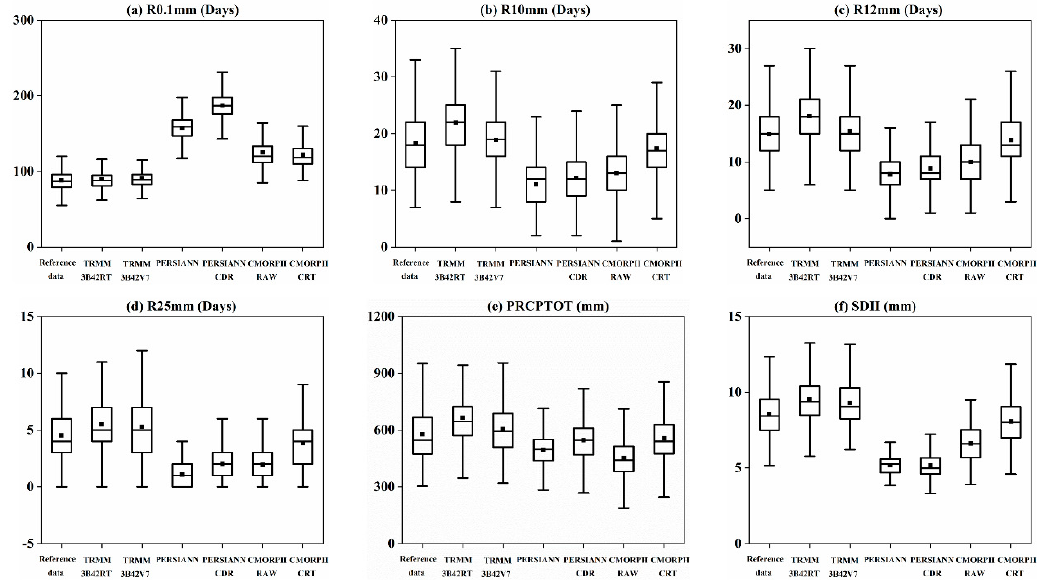
Figure 7. Boxplots for the six absolute threshold indices ( a ) R0.1mm, ( b ) R10mm, ( c ) R12mm, ( d ) R25mm, ( e ) PRCPTOP and ( f ) SDII for the reference data and the six SPPs. The upper and lower edges of the box mark the upper and lower quartiles (75% and 25%, respectively). The solid line in the box marks the median value. The uppermost and lowermost horizontal lines mark the 1.5I QR outliers. The point marks the average value.